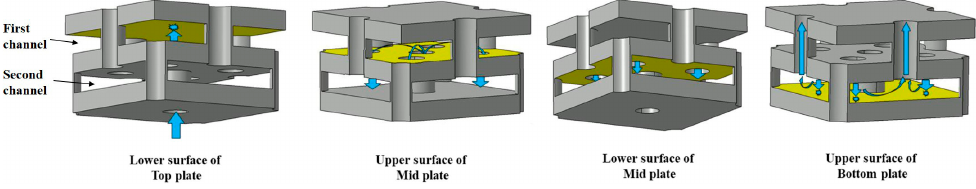
Figure 25. Impingement/effusion cooling created by three perforated plates with hollow-cylinder structures. Adapted with permission from [114]. Copyright 2021 Elsevier.